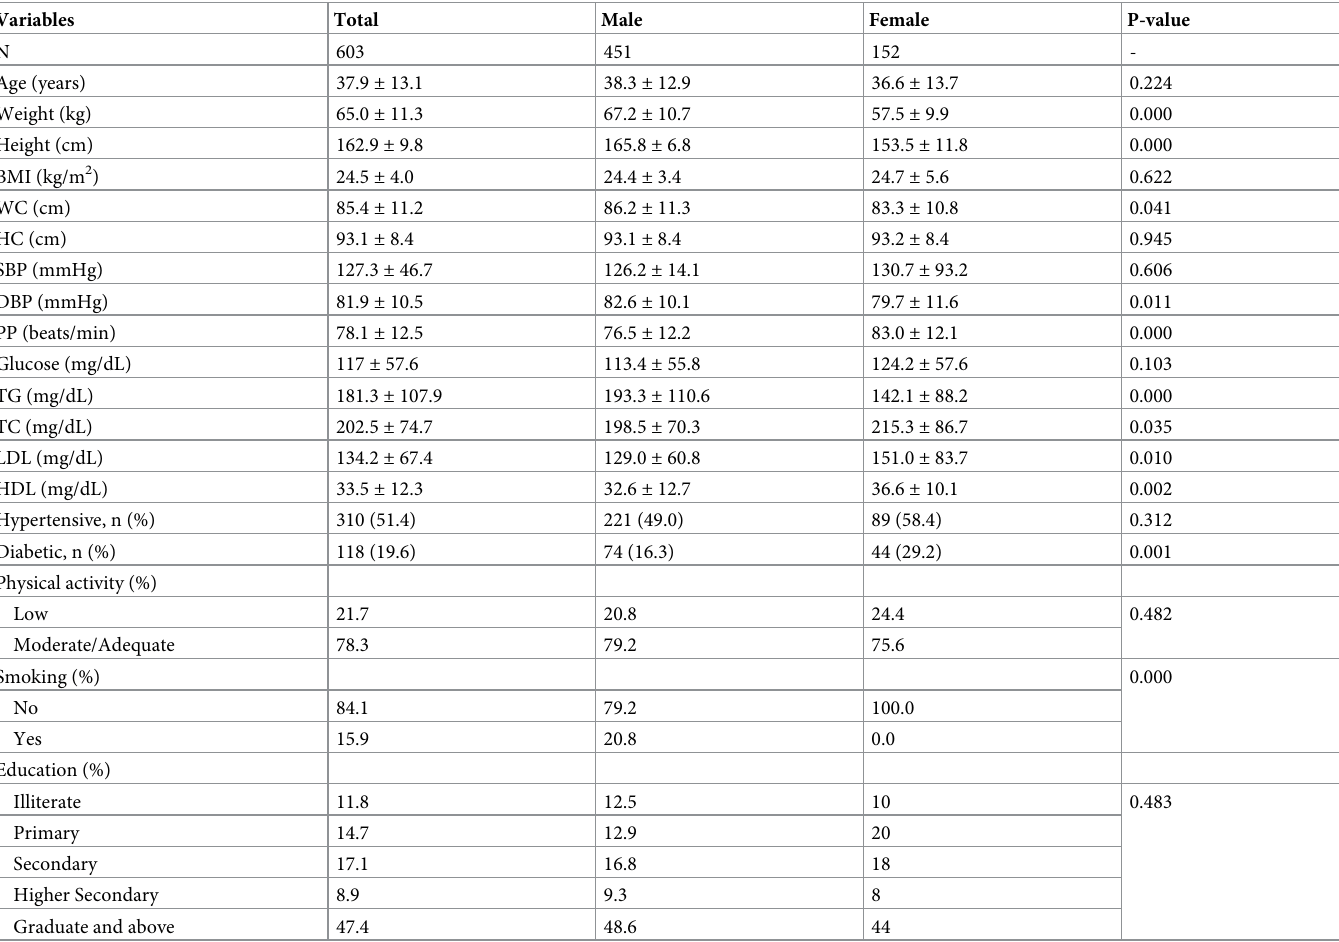
Table 1. Baseline characteristics of the study